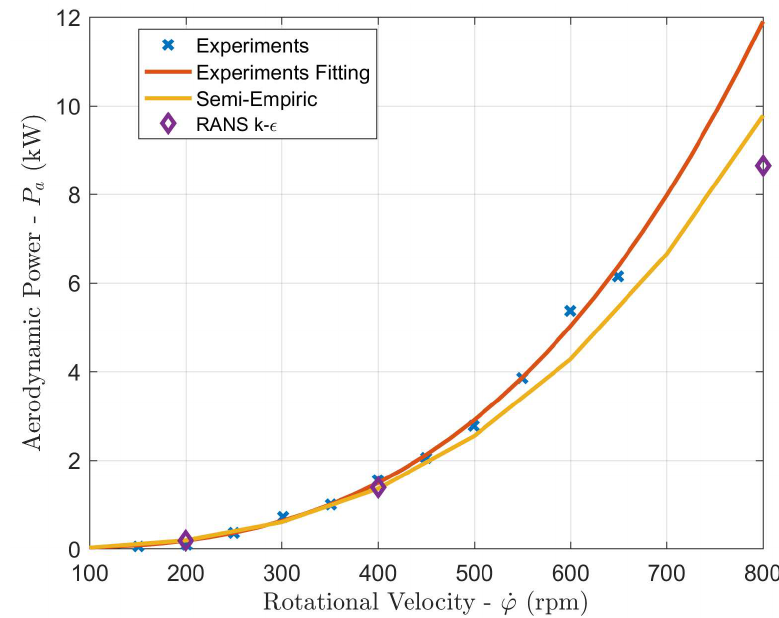
Figure 15. Aerodynamic power: Free configuration results comparison against available experimental data.